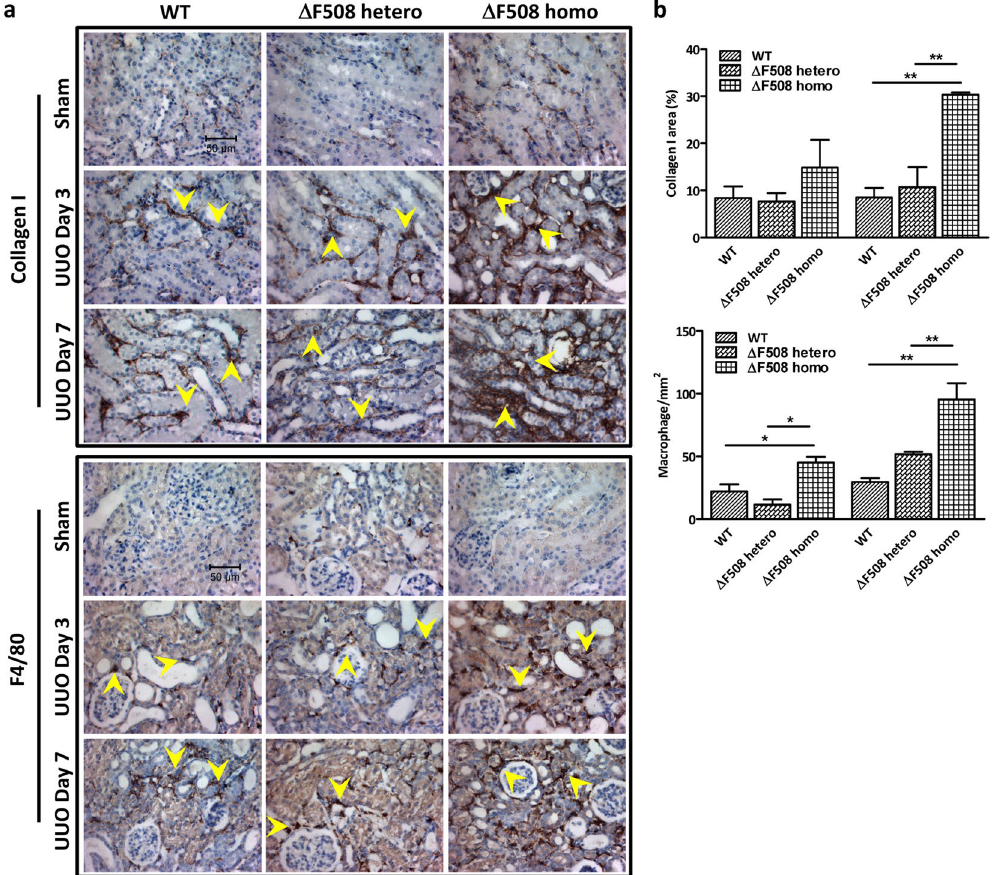
Figure 5. Development of kidney fibrosis is aggravated in delta F508 mice. ( a ) CFTR mutation aggravates kidney fibrosis manifestation in delta F508 mice compared to wild type mice after UUO procedure. Collagen I staining and F4/80 staining; ( b ) Quantification analysis of Collagen I staining and F4/80 staining, representing mean ± SEM from three mice. * P < 0.05, ** p < 0.01, *** p < 0.001 compared with wild type